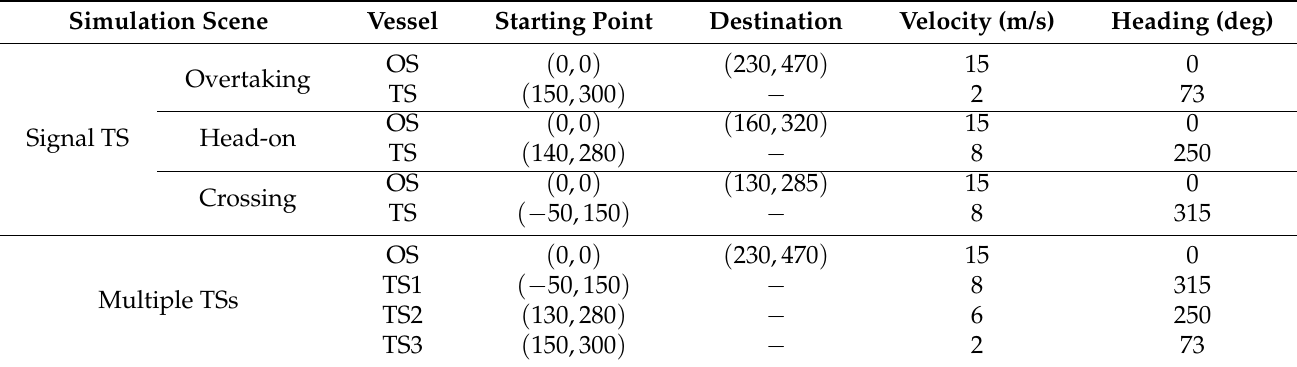
Table 2. Motion parameters for the OS and